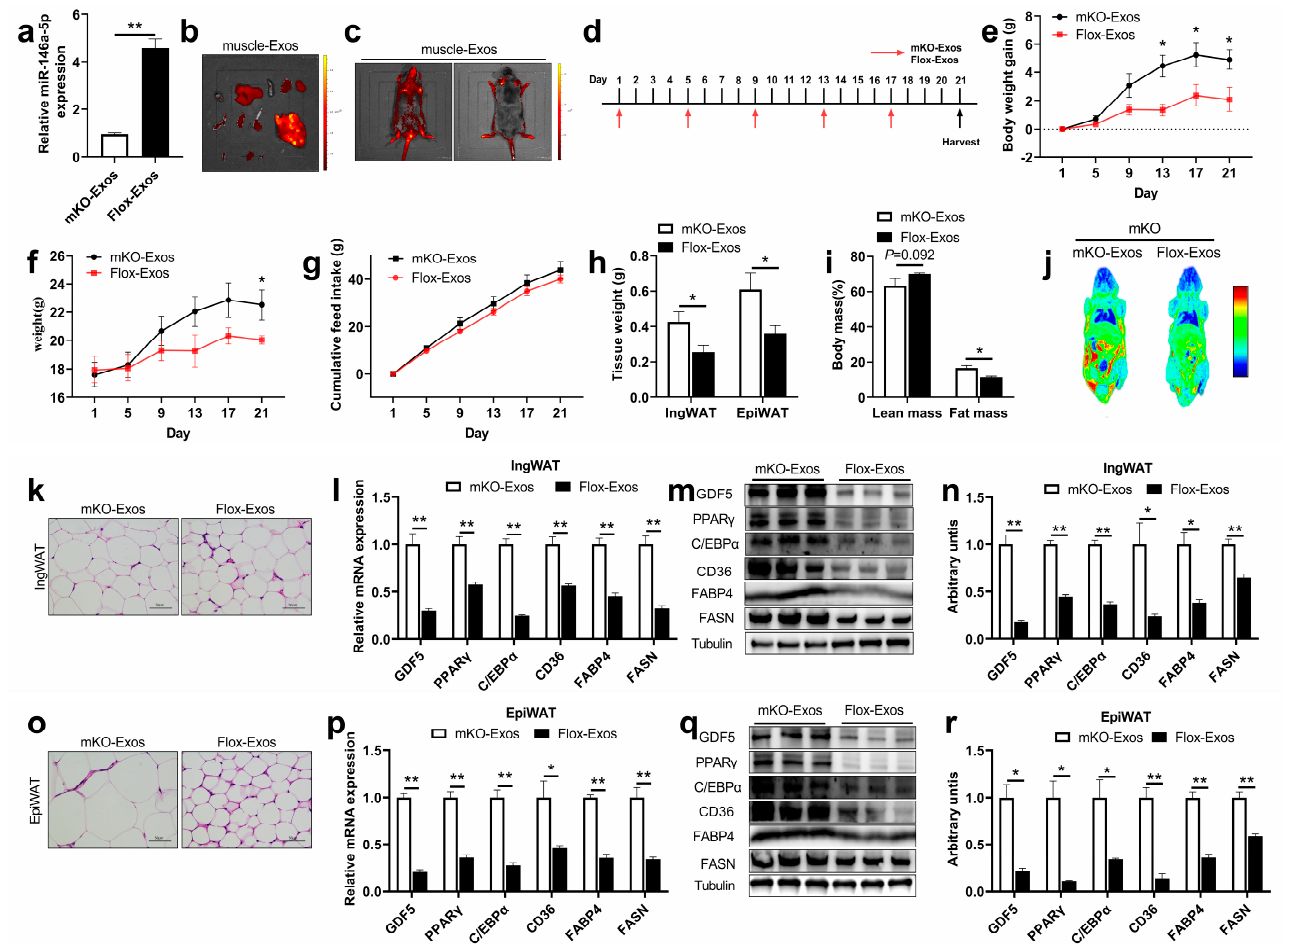
Figure 7. The intravenous injection of Flox-Exos into mKO mice reversed the inhibition of adipogenesis. ( a ) Expressions of miR-146a-5p were determined in skeletal muscle-derived exosomes from mKO and Flox mice (n = 6). ( b ) The fluorescence signal of skeletal muscle-derived exosomes in isolated mKO mice organs 24 h after tail vein injection. The isolated organs from left to right are as follows: heart, liver, spleen, lung, kidney, BAT, IngWAT, EpiWAT, whole intestine, TA, EDL, GAS, SOL. ( c ) In vivo imaging of mKO mice 24h after tail vein injection of PKH67-labeled skeletal muscle-derived exosomes. ( d ) Schematic diagram of tail-vein injections of Flox-Exos and mKO-Exos administered to HFD-fed mKO mice at the age of 6 weeks. ( e ) Body weight gain in mKO mice (n = 3). ( f ) Body weight of mKO mice (n = 3). ( g ) Accumulate feed intake of mKO mice fed HFD (n = 3). ( h ) Tissue weight (IngWAT and EpiWAT) of mKO mice (n = 3). ( i ) Body Composition of mKO mice (n = 3). ( j ) Body imaging of mKO mice. ( k ) IngWAT HE staining image of mKO mice. ( l ) Expression of adipogenesis and fatty acid synthesis-related genes 21 days after exosome